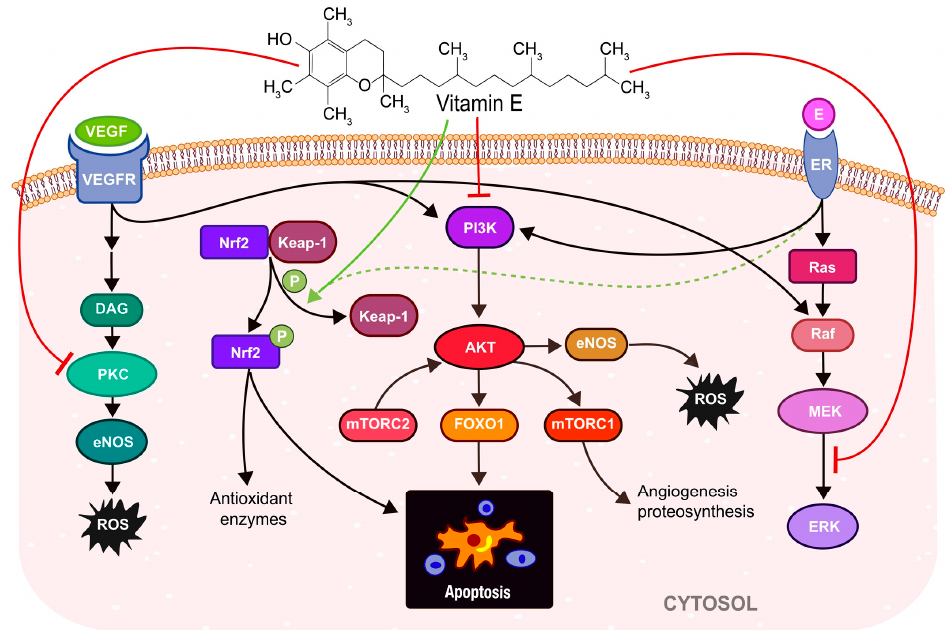
Figure 2. Vitamin E (tocopherol) action in response to oxidative stress. It can stimulate Nrf2 (Nuclear factor erythroid 2–related factor 2) signaling (green arrow) and cell apoptosis. Tocopherol can affect signaling of growth factors (Vascular Endothelial Growth factor, VEGF) and hormones (estrogen, E) by inhibition of PKC (Protein kinase C) (red line), which activates protein phosphatase, and dephophorylates PKC and inhibits its activity, which in turn leads to lower ROS mediated via uncoupled eNOS. Tocopherol also suppress E-dependent ERK activation (red line) via its ability to bind to the estrogen receptor (ER). On the other hand, vitamin E can inhibit apoptosis through the PI3K/AKT/mTOR pathway (red line). (VEGFR—Vascularendothelial Growth Factor Receptor,